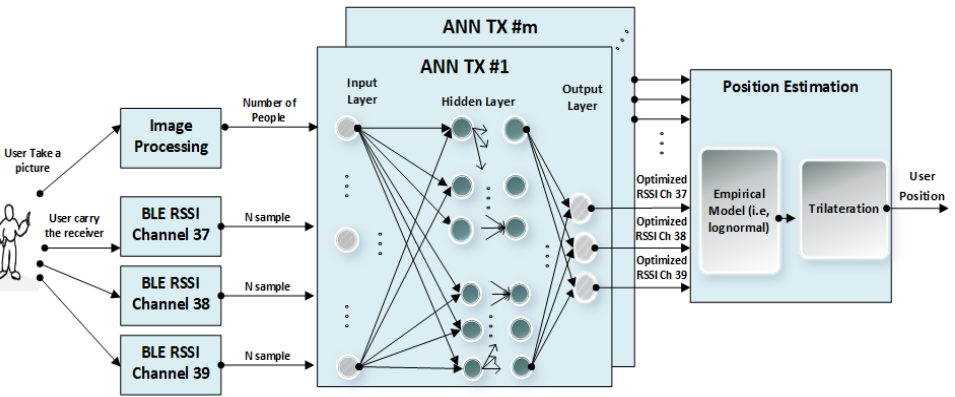
Figure 6. The general overview of the proposed system.